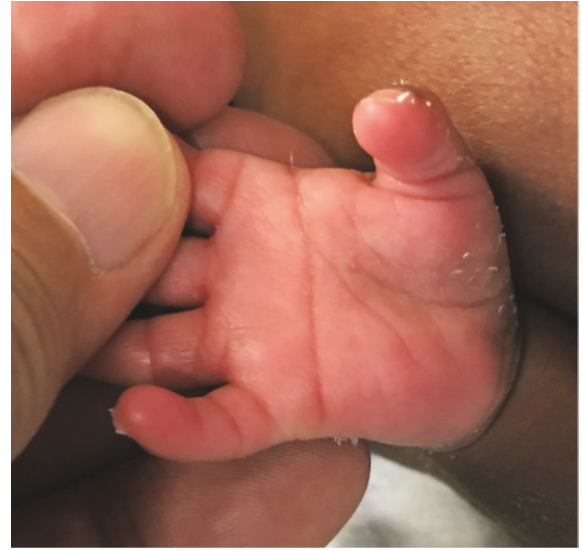
Figure 3: Photo showed palmar crease.